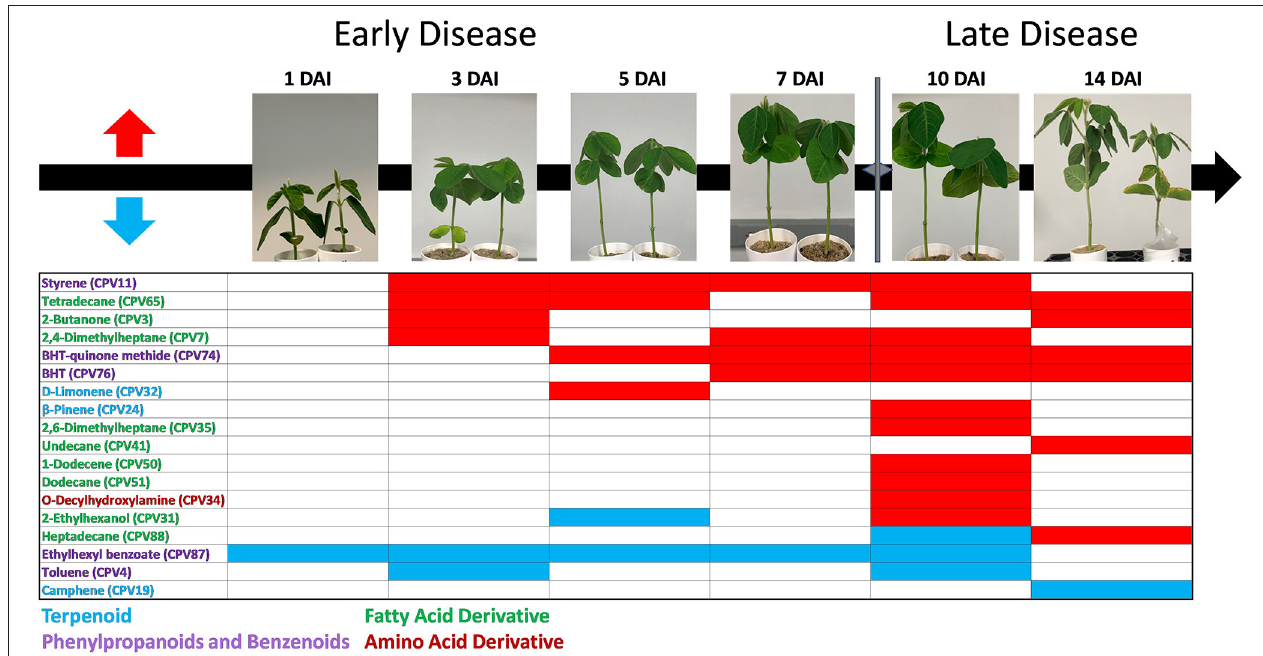
FIGURE 7 | Temporal expression patterns of identified CPVs with significant differences in expression between SCN infested and mock treatments. Time points were 1, 3, 5, 7, 10, and 14 DAI. Red blocking indicates statistically significant emission and blue blocking indicates significant suppression of VOCs by infested plants (permutation test P < 0.05; n = 20). BHT-quinone methide and BHT abbreviations for 2,6-Di-T-butyl-4-methylene-2,5-cyclohexadiene-1-one and Butylated Hydroxytoluene, respectively. Images show representative mock (left) and SCN infested (right) plants at different